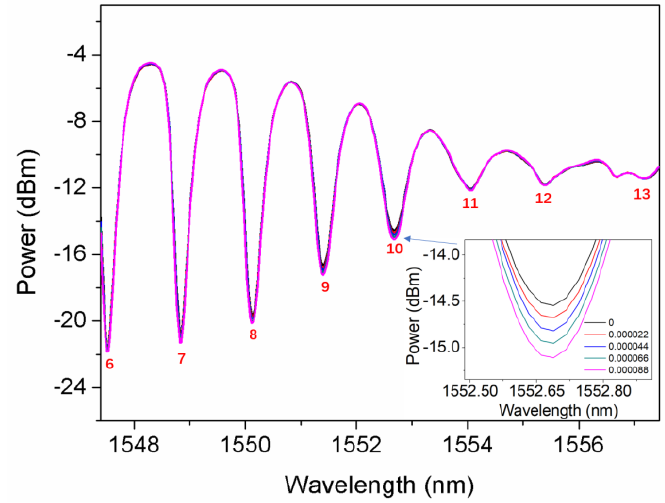
Figure 6. Spectra adjacent to the SPR signature in different glucose aqueous solutions (refractive index ~1.3573) with a SRI change of 8.8 × 10 − 5 ; inset: zoomed-in spectra of the most sensitive cladding mode No. 10.